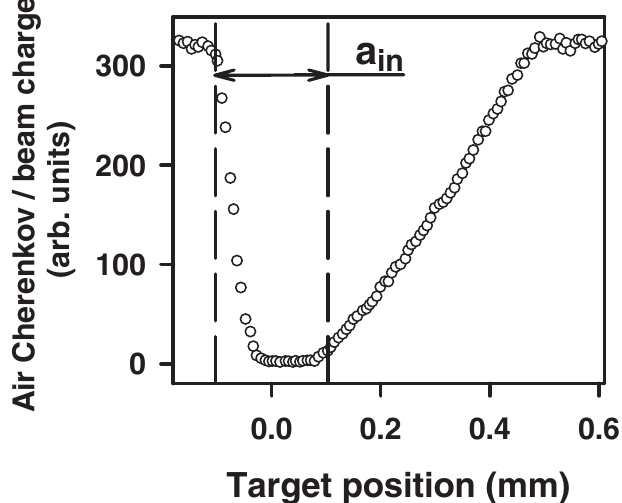
FIG. 12. Forward bremsstrahlung photon yield as a function of the target position normalized by the electron beam charge (open circles). Zero target position corresponds to the slit center and two dashed lines represent the effective slit width ( a